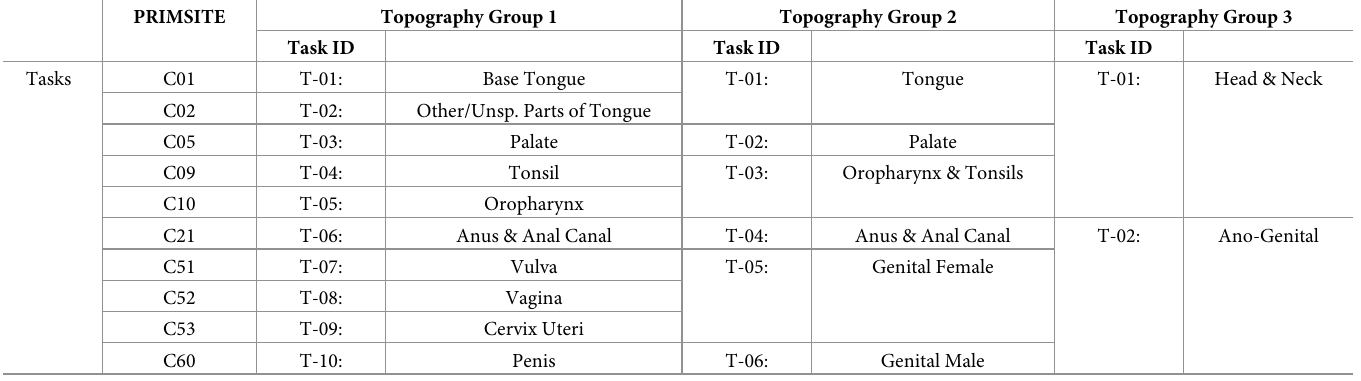
Table 2. ICD-O-3 codes included in the cohort and topography group division used in our experiments.